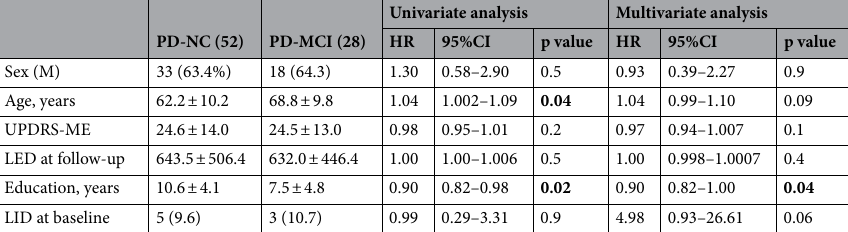
Table 3. Predictors of mild cognitive impairment at follow-up. PD-NC: Parkinson’s disease-normal cognition; PD-MCI: Parkinson’s disease-mild cognitive impairment; M: male; UPDRS-ME: Unified Parkinson’s Disease Rating Scale-Motor Examination; LED: levodopa equivalent dosage; LID: levodopa induced dyskinesia.